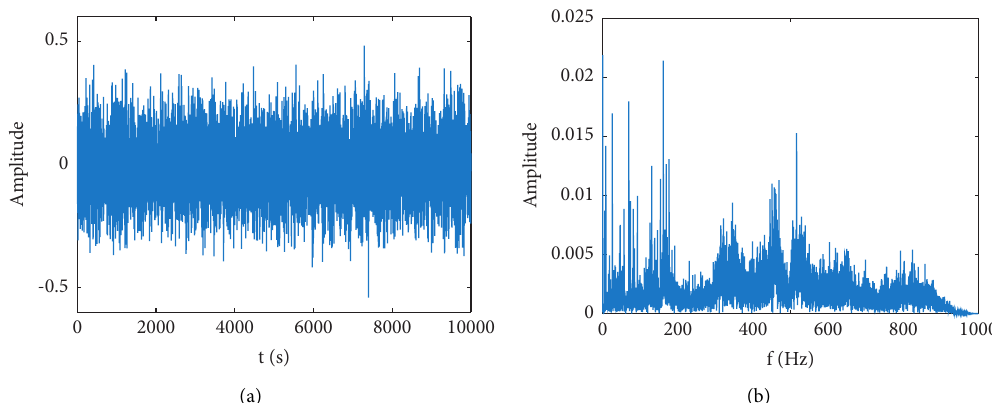
Figure 4: Waveform of normal signal. (a) Time-domain diagram of normal signal. (b) Frequency-domain diagram of normal signal.